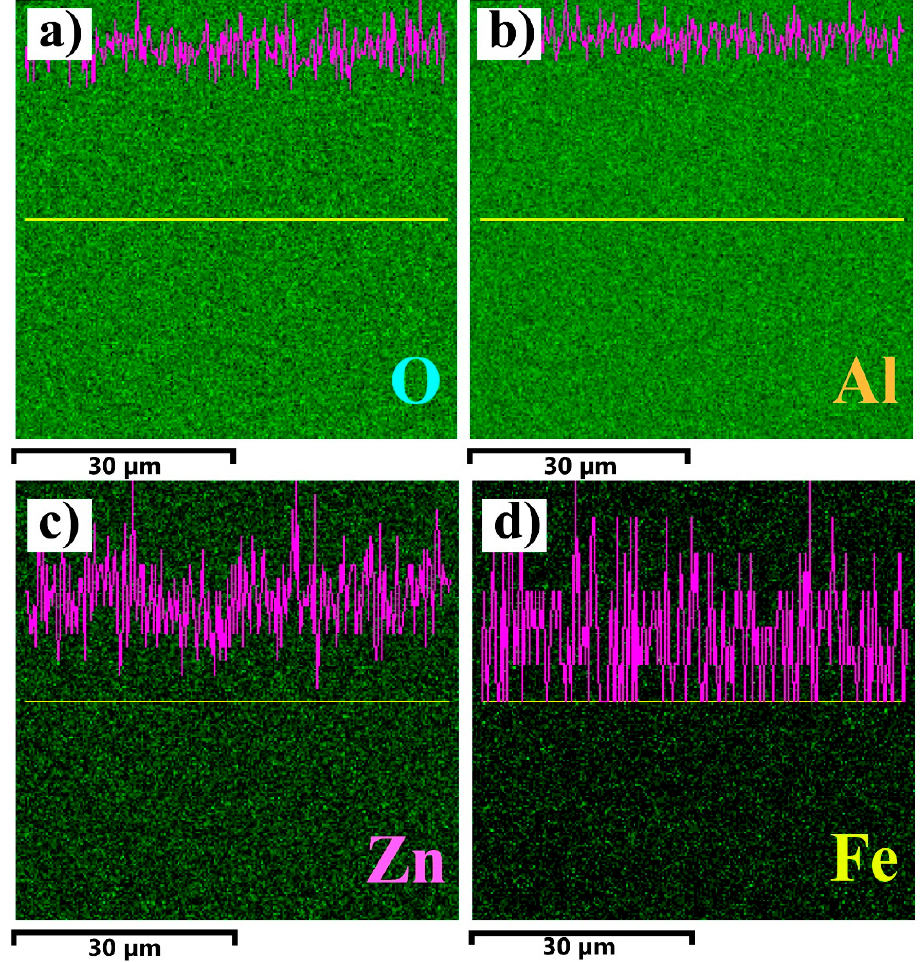
Figure 7. EDX elemental mapping analysis and X-ray intensity of characteristic lines of O ( a ), Al ( b ), Zn ( c ), and Fe ( d ) elements.